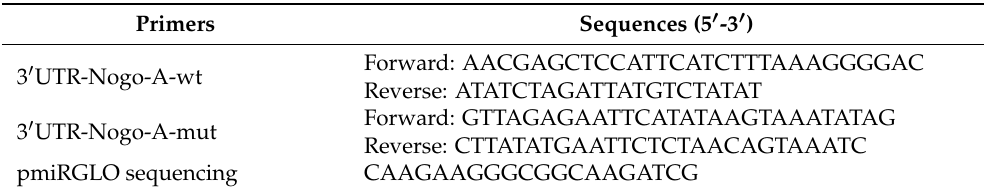
Table 1. Primers used for subcloning of 3 (cid:48) UTR-Nogo-A-wt and 3 (cid:48) UTR-Nogo-A-mut fragments, as well as for DNA